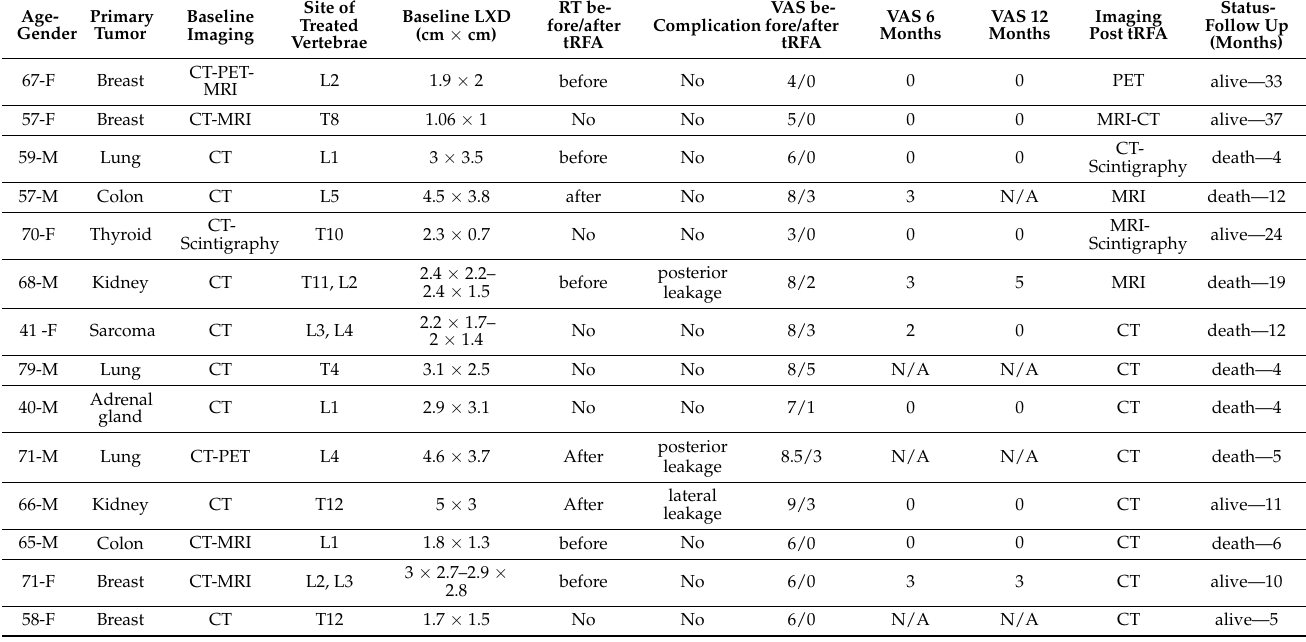
Table 3. Group B (patients with more than two vertebral metastatic